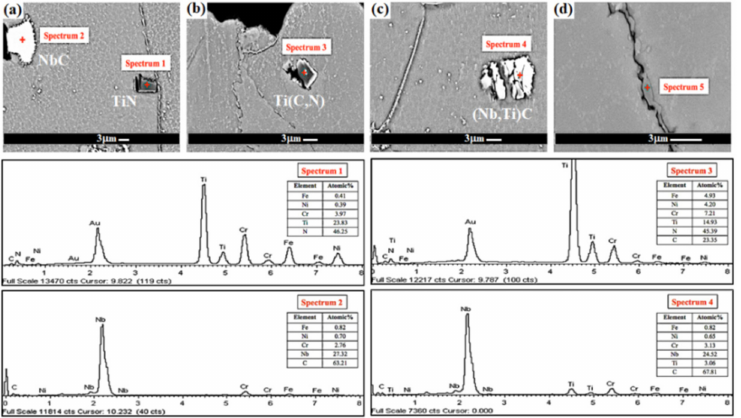
Figure 13. ( a – d ) FESEM images and corresponding EDX analysis for spectrums 1, 2 and 3 of Fe-40Ni- 24Cr after creep test at 900 ◦ C under 100 MPa